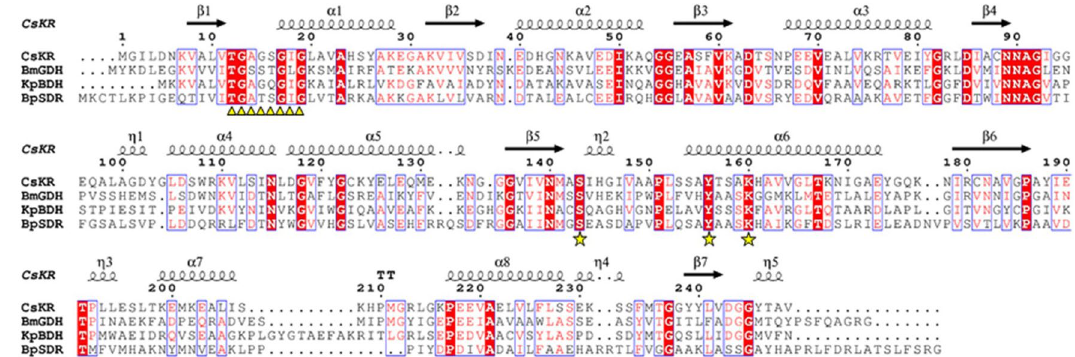
Figure 2. Multiple sequence alignments of BPSS2242 and other members of SDR superfamily. The alignment was performed using BioEdit program and rendered by ESPript. The secondary structure of CsKR was shown above the alignment. The consensus sequence of NAD(P)(H)-binding motif and catalytic triad are highlighted by triangles and stars, respectively.